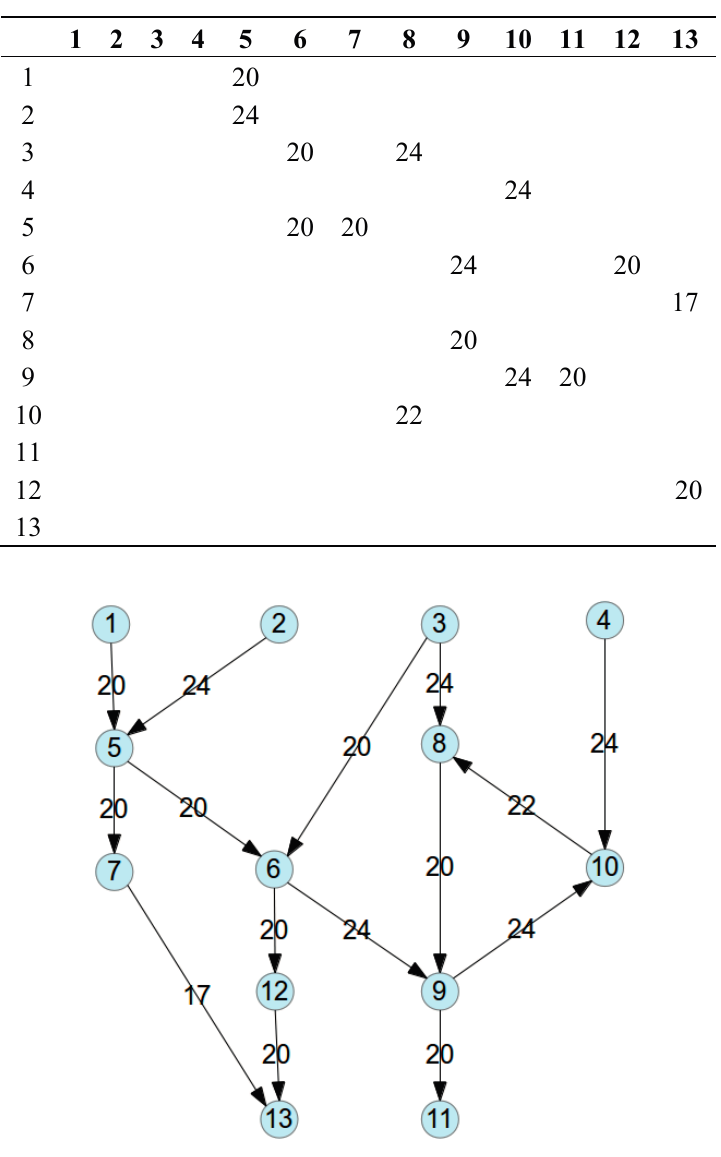
Table 3. Graph example: overlaps matrix.